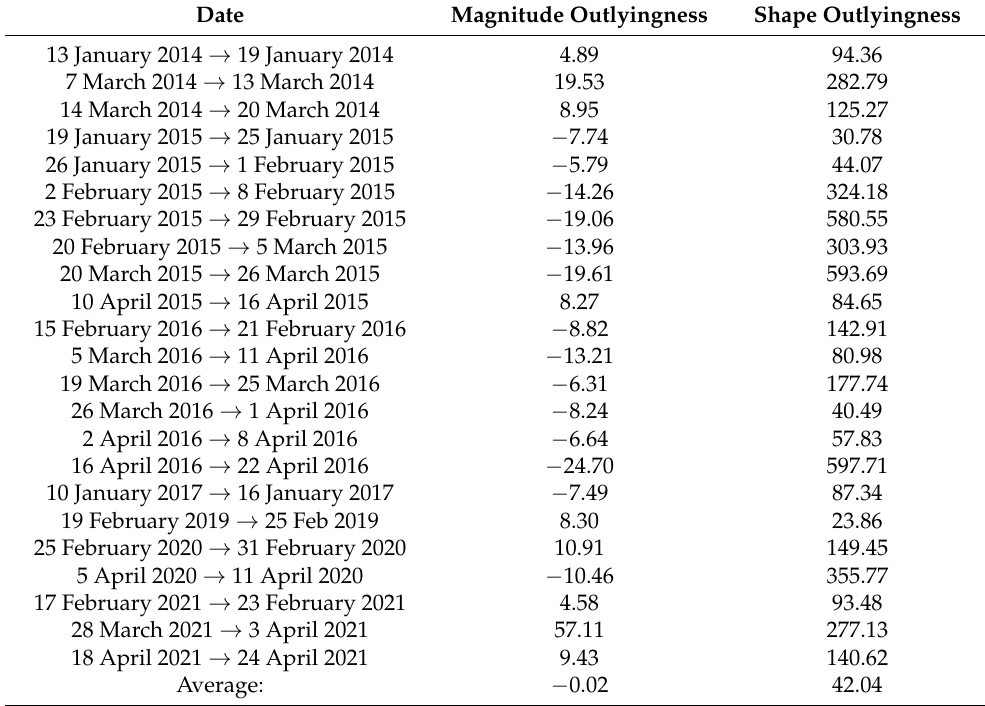
Table 3. Weekly PM 10 outliers of the improved method with the modified band depth. The first column includes those outlying weeks of the first four months of every year, defined by their first and last day. The second column presents the magnitude outlyingness of those functions, which quantifies how much a function is shifted compared to the rest. The last column shows the shape outlyingness, a parameter that expresses to what degree a function has a different structure than the